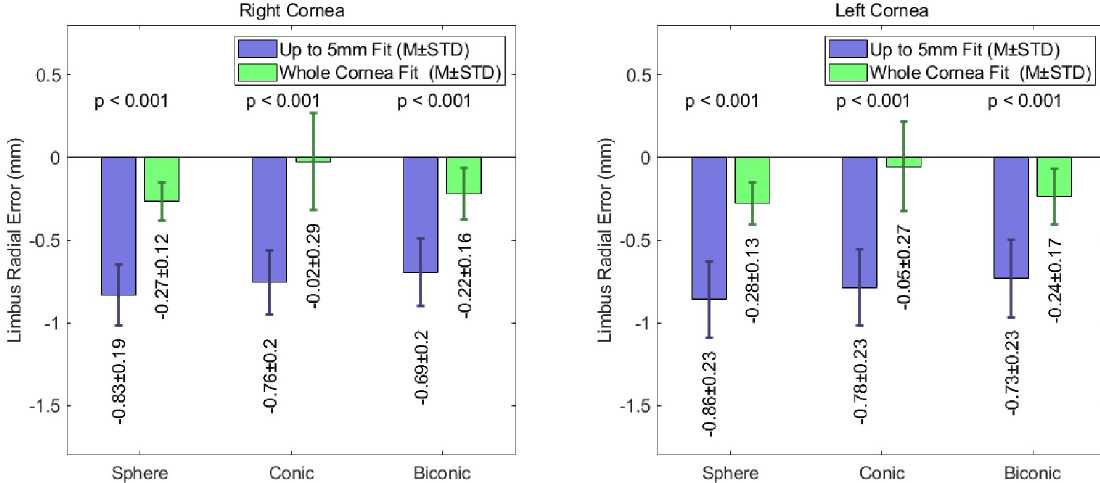
Fig 7. Limbus radial position error of fitted limbus compared to detected limbus when spherical, conic and biconic fitting modelling techniques limbus, for spherical, conic and biconic modelling techniques.